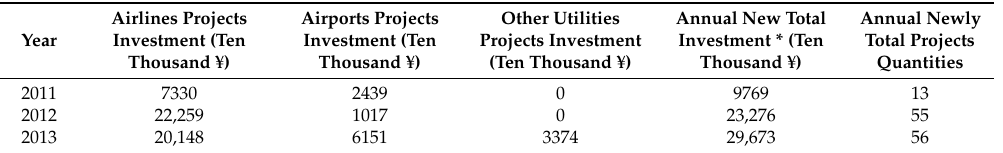
Table 2. The overview of Energy Conservation and Emission Reduction projects in Beijing-Tianjin-Hebei region from 2011 to